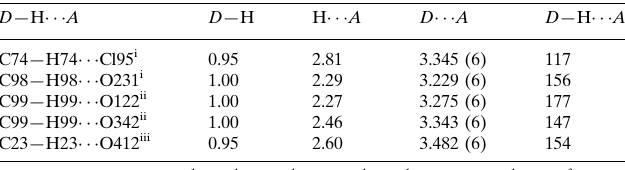
Hydrogen-bond geometry (A˚ , (cid:2)